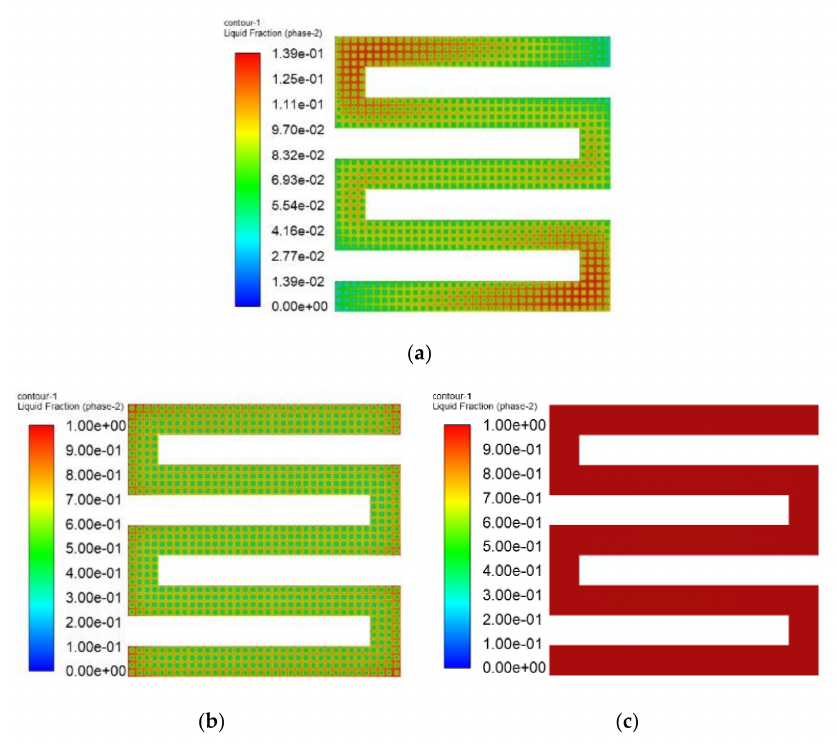
Figure 28. The fuel cell temperature contours with pore diameter = 0.6 mm at di ff erent times; ( a ) t = 30 s, ( b ) t = 38 s, ( c ) t = 46